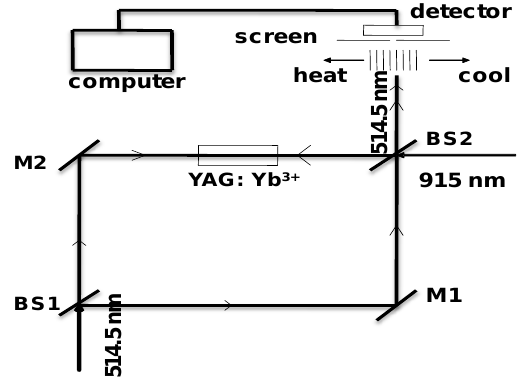
Figure 13. Interferometer fringes produced by a 514.5 nm laser. The dark spot is the pin hole in front of the detector [36].